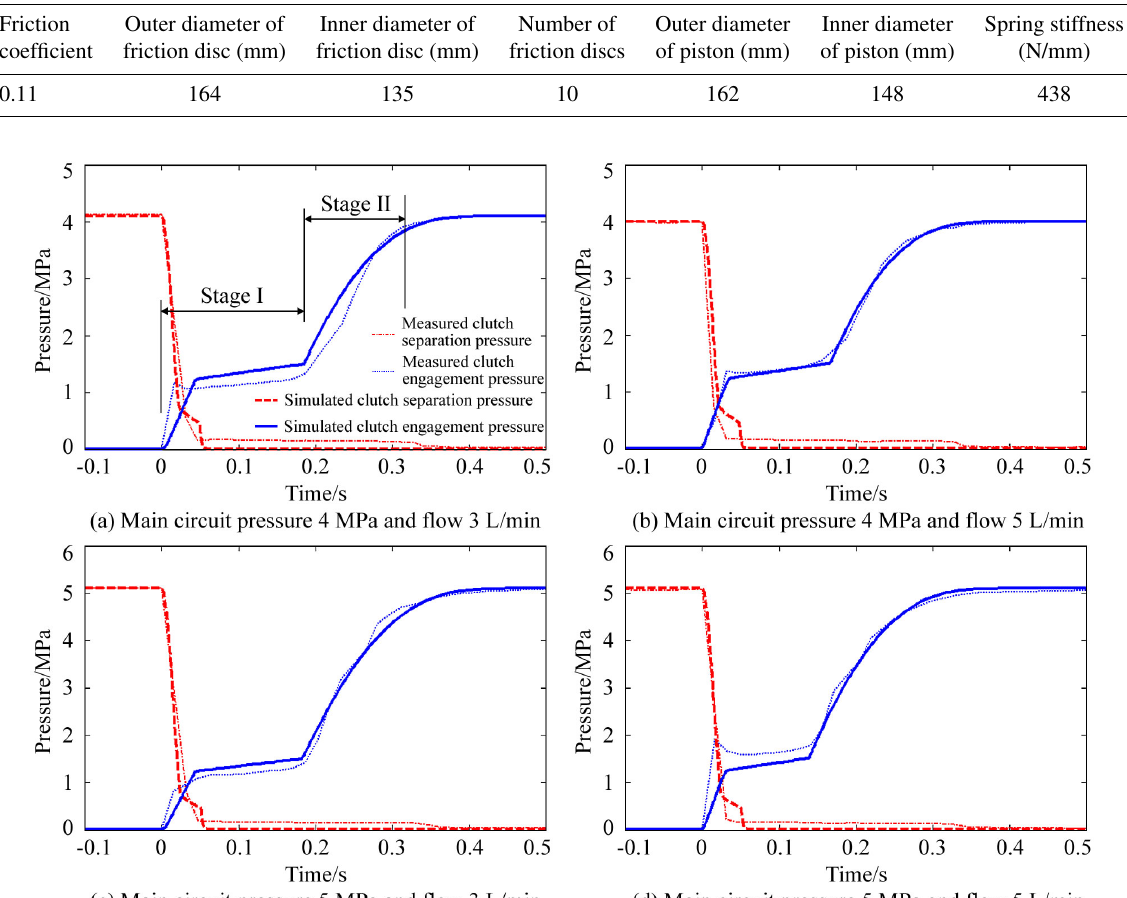
Figure 5. Pressure response of wet